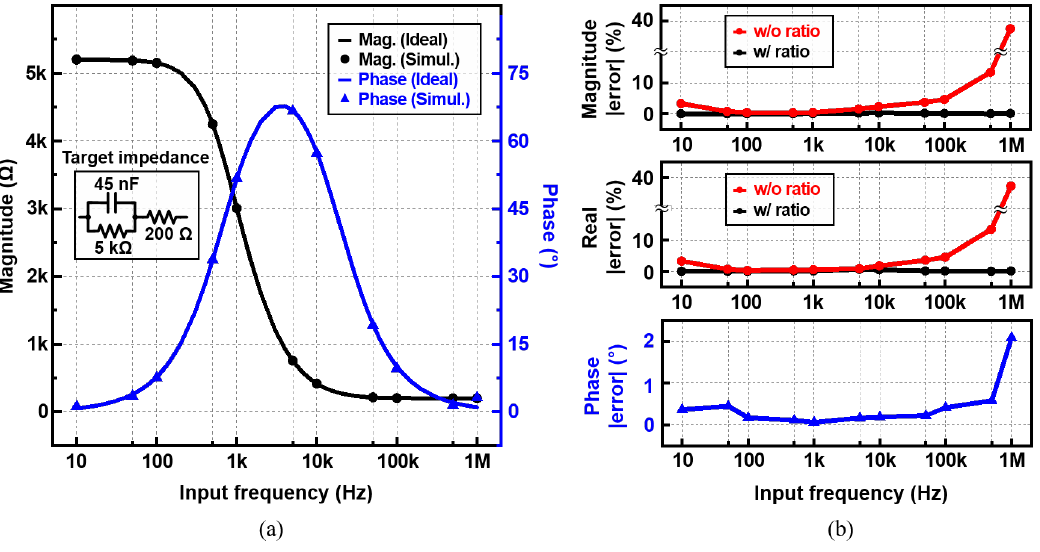
Figure 14. Simulated ( a ) magnitude, phase, and ( b ) the errors obtained using the proposed measure- ment IC over the input frequency ( f in ).